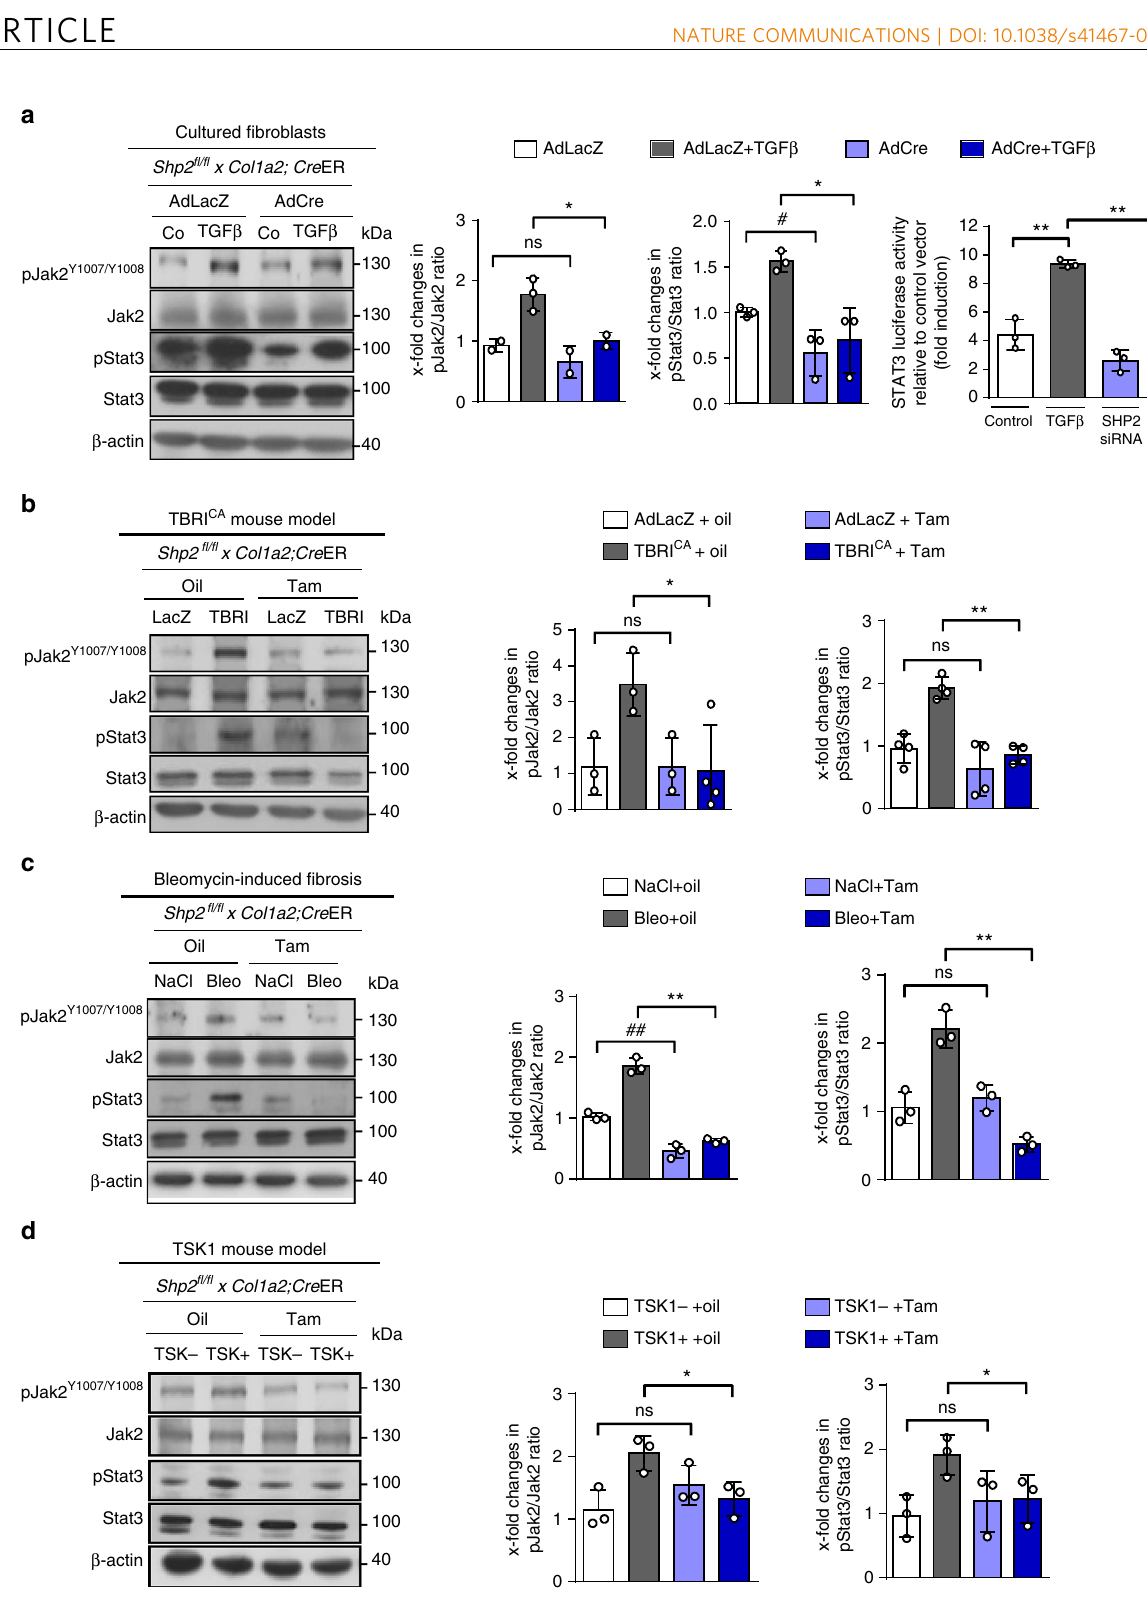
Fig. 5 Knockout of Shp2 decreases JAK2/STAT3 signaling. a Knockout of Shp2 in fi broblasts ( Shp2 fl / fl x Col1a2 ; Cre ER) decreases the levels of pJAK2 and pSTAT3 and STAT3 reporter activity in cultured fi broblasts ( n = 3 different lines). Cells were stimulated with TGF β (10 ng/ml for 6 h). b – d Conditional knockout of Shp2 reduces the levels of pJAK2 and pSTAT3 in TBRI CA (6.67 × 10 7 IFUs every 2 weeks) ( b ) and bleomycin-induced fi brosis (50 µ g every other day) ( c ) and in TSK1 mice (2 mg tamoxifen over 5 days) ( d ) ( n ≥ 3). Results shown are representative of three independent experiments. All data are presented as median± s.e.m. The p values are expressed as follows: 0.05 > p > 0.01* or # ; 0.01 > p > 0.001** or ## ; p < 0.001***; ns: not signi fi cant. Signi fi cance was determined by Mann – Whitney test. AdLacZ or LacZ: adenovirus LacZ, TBRI CA or TBRI: constitutively active TGF β receptor type I,